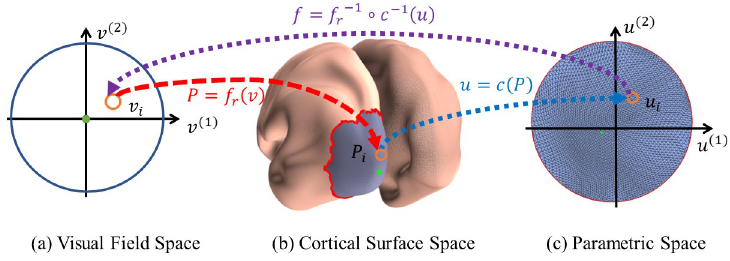
Fig 4. Illustration of (A) the visual field space, (B) the cortical surface space, and (C) the parametric space.